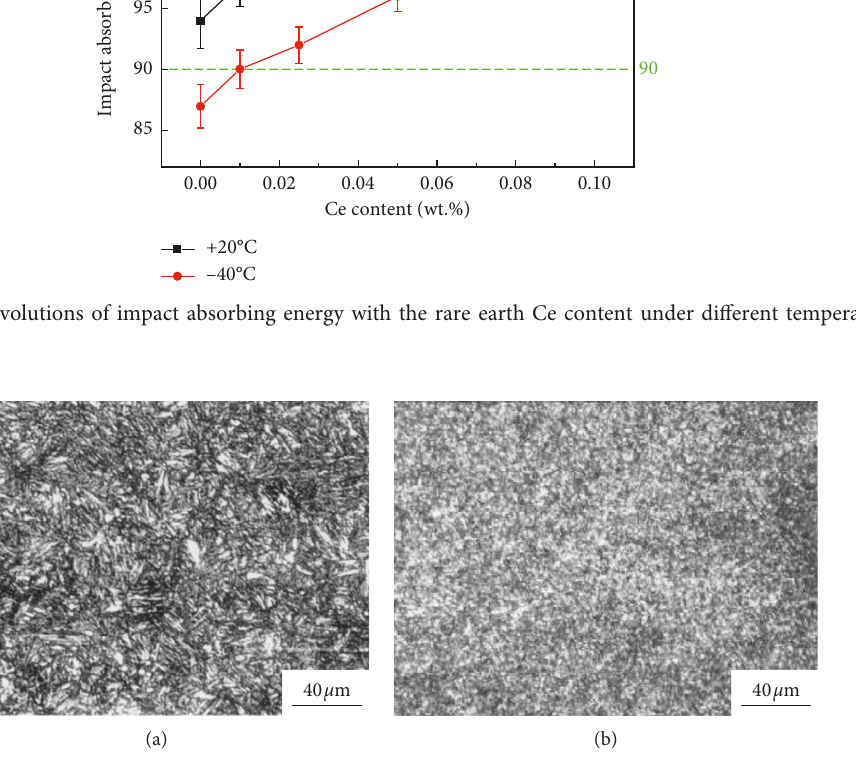
Figure 9: The metallographs of 34CrNiMo6-0.05Ce specimens quenched in oil (870 ° C/30 min) and then tempered at 650 ° C: (a) as quenched in oil; (b) quenched and tempered.